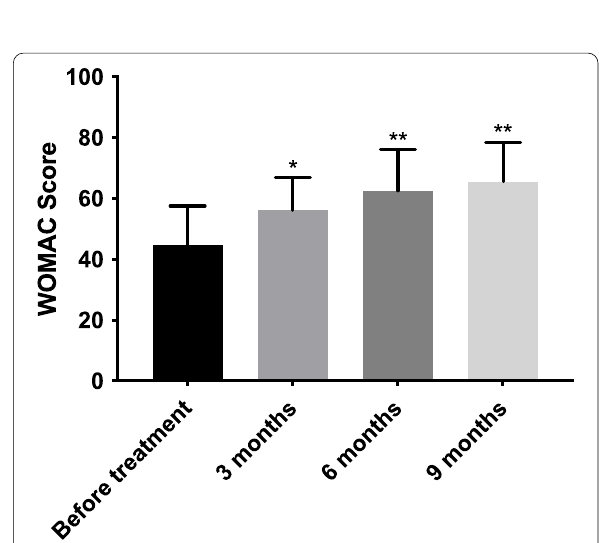
Fig. 2 Mean functional Western Ontario and McMaster Universities Arthritis Index (WOMAC) scores ( n 24) before and after Lipocell = treatment. Error bars show standard deviation. * p vs. before treatment < 0.05; ** p vs. before treatment <